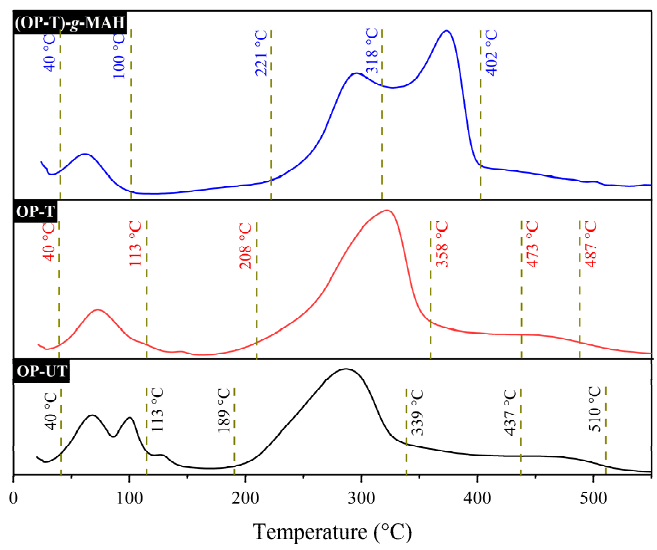
Figure 9. TGA curves of OP-UT, OP-T and (OP-T)- g -MAH.